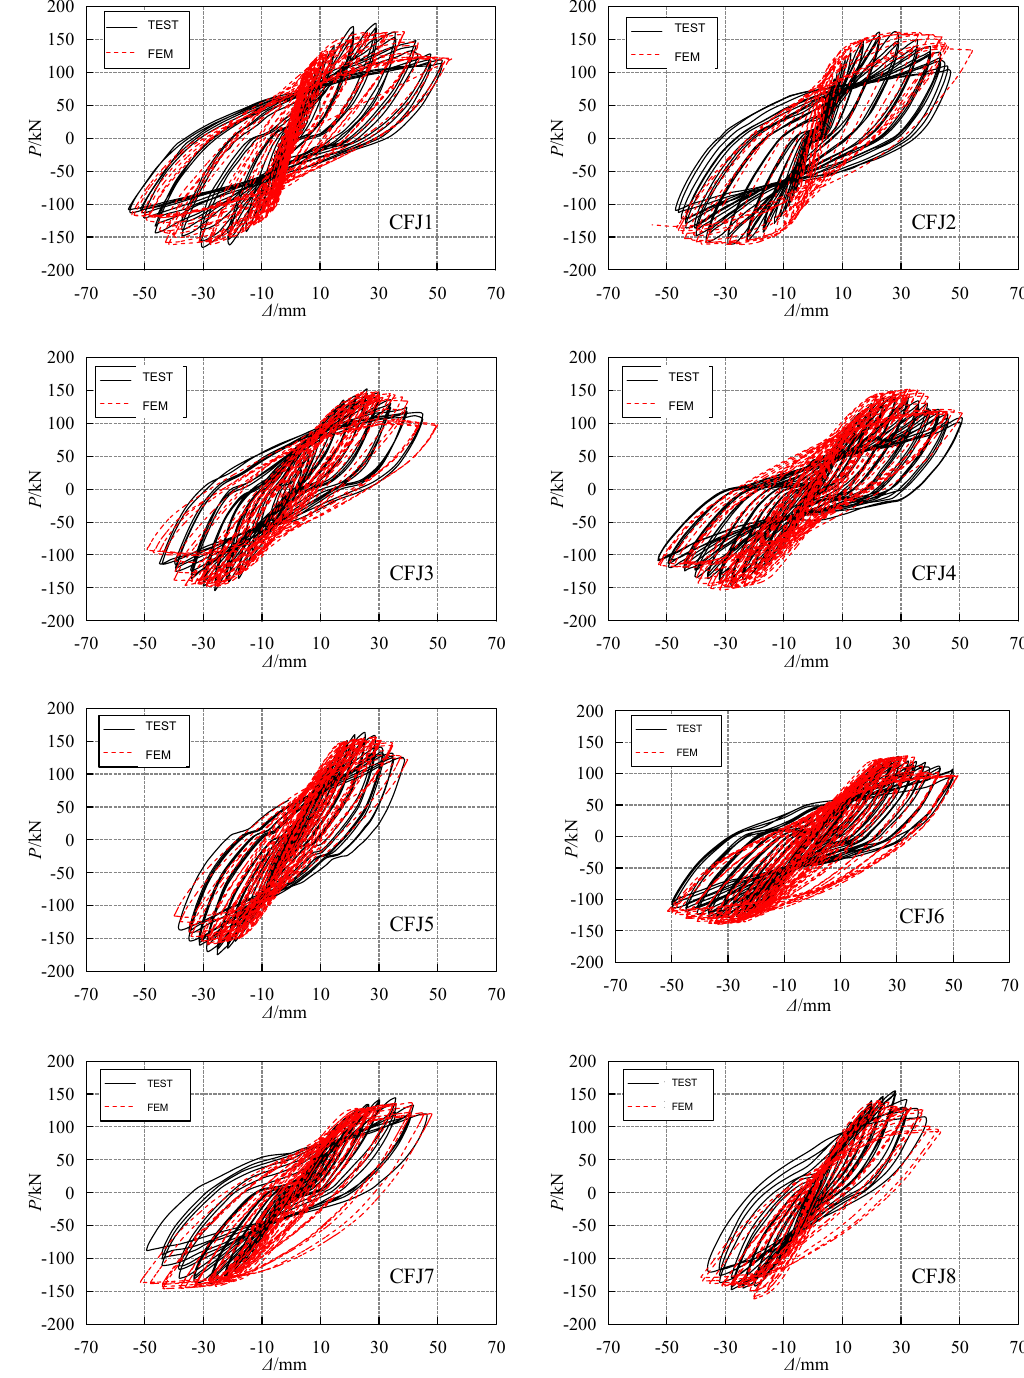
Figure 13. Comparison of test and simulation results of hysteretic curves of composite joints. The hysteretic curves in Figure 13 and the skeleton curves in Figure 14 pinpoint that the simulation results of the hysteretic characteristics of the composite joints are basically in good agreement with the experimental results. However, compared with the experimental curves, the pinch effect of the simulated hysteretic curve of the exterior joints (CFJ6–CFJ8) is far from expectation. The unloading stiffness of the simulated curve is relatively larger. The main reason may be that the exterior joints are asymmetric structures. In addition, the cumulative damage of positive loading is greater than that of negative loading in the simulation. When the cumulative damage of positive loading reaches a certain degree,